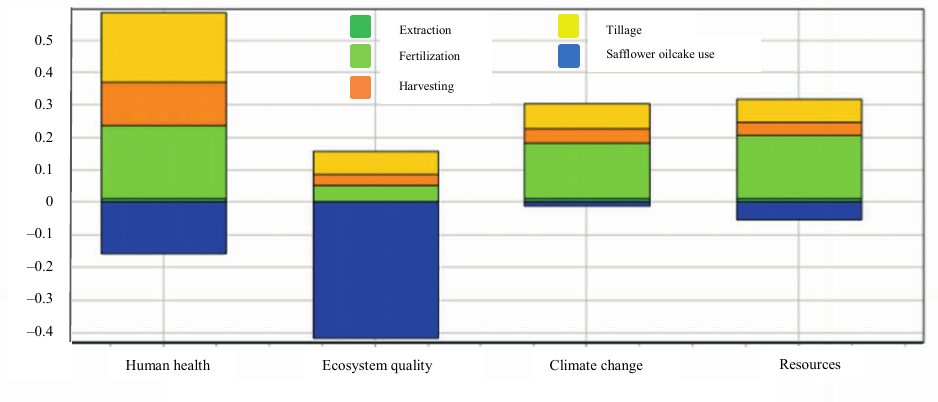
Fig. 3. Environmental impact of the various components of the production cycle of safflower oil referring to one ton of oil produced; normalization phase, end-point